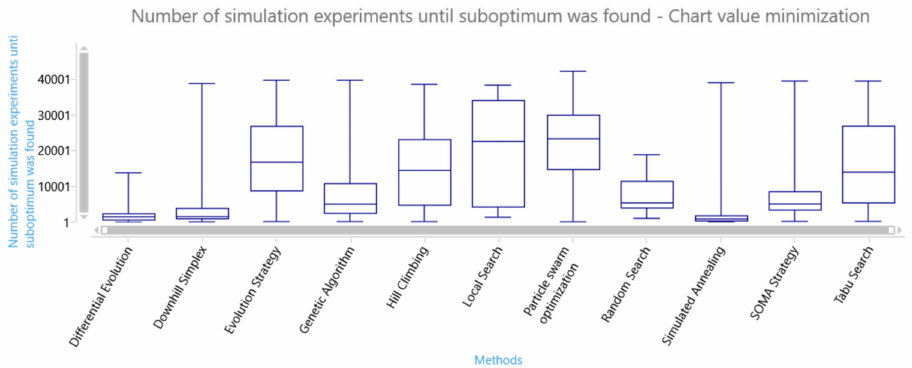
Figure 18. Box plot of the speed of finding a suboptimum of the objective function—25% of the best series.